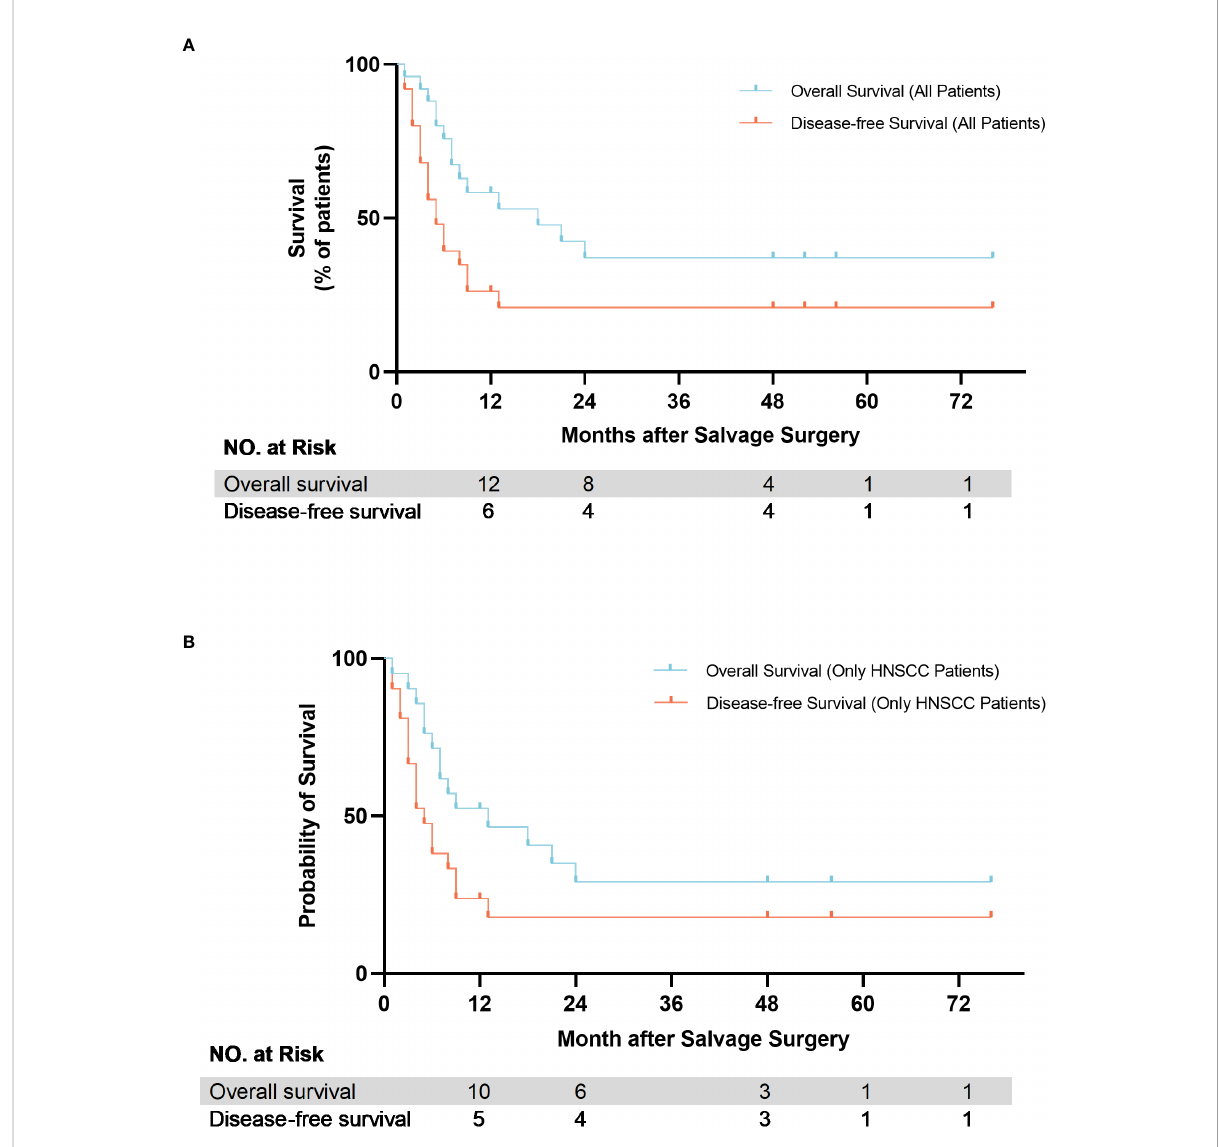
FIGURE 4 Kaplan-Meier estimate of overall survival (OS) and disease-free survival (DFS) of patients after salvage surgery. (A) All patients; (B) HNSCC patients